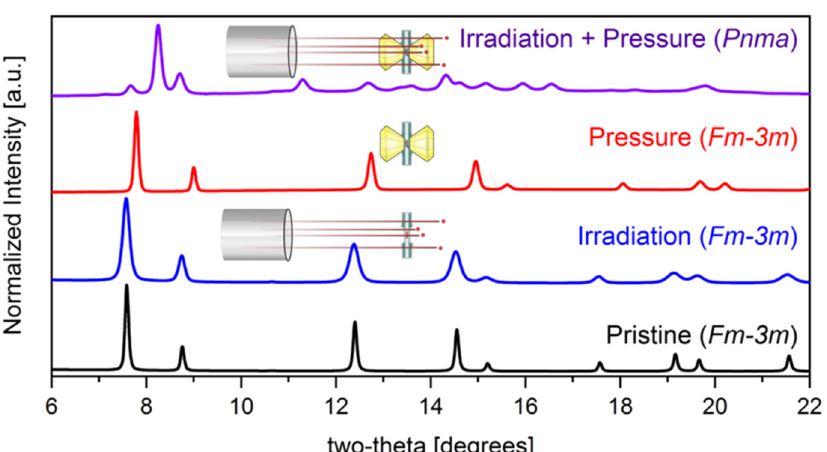
Figure 8. X-ray diffraction patterns of CeO 2 exposed to 4 × 10 12 946 MeV 197 Au ions/cm 2 at ambient conditions (blue), pressurized to 21.7 GPa in a diamond anvil cell (DAC) in the absence of irradiation (red), and exposed to a combination of pressure and irradiation, utilizing compression in a DAC to 21.8 GPa and irradiation with 7100 MeV 238 U ions to a fluence of 4 × 10 12 ions/cm 2 (violet). Irradiation with 7100 MeV 238 U ions to a fluence of 4 × 10 12 ions/cm 2 at a pressure of only 21.8 GPa (roughly 10 GPa below the typical transformation onset pressure) triggers